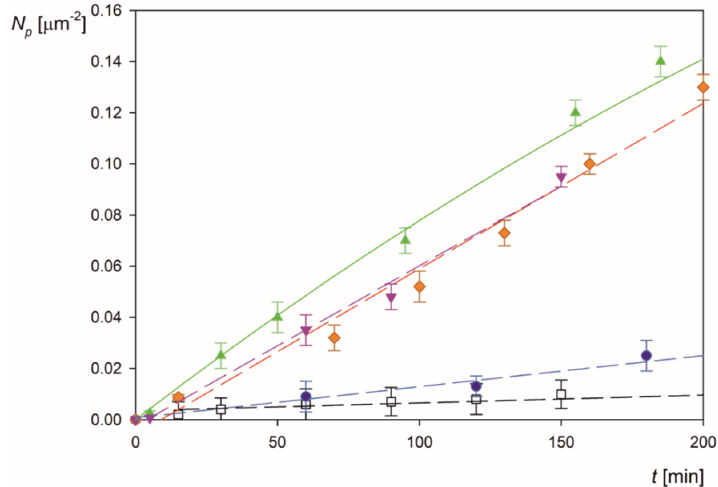
Figure 8. Kinetics of LSFi particle deposition at the mica/PLL substrate in the OBIJ flow cell, shown as the dependence of the surface concentration on the deposition time, particle concentration 50 mg L − 1 , 0.01 mol L − 1 NaCl, flow rate 2.5 × 10 − 3 cm 3 s − 1 . The points show the results obtained for various pHs: pH 9 ( ▼ ); pH 7.4 ( ♦ ); pH 6.5 ( ▲ ); pH 4.5 ( ● ); pH 3.5 ( □ ). The solid line shows the theoretical results derived from the convective diffusion model with the RSA blocking function.